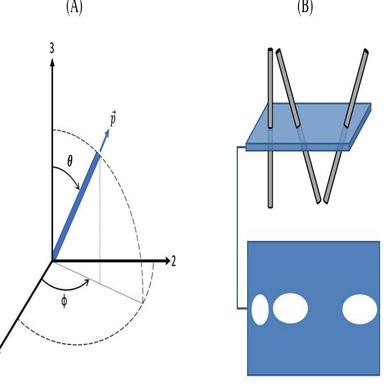
Schematic (A) showing the in-plane angle ϕ and the out-of-plane angle θ used to describe the 3D orientation of a fiber, and schematic (B) showing the elliptical cross-sections of three fibers, two of which have equal magnitude but opposite signs of θ.